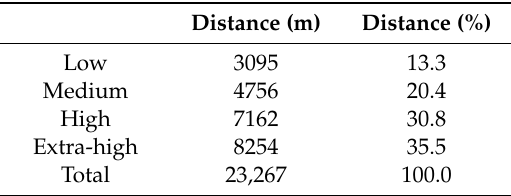
consumption in WLTP procedure (ECT, WLTP). Table 8. WLTP procedure